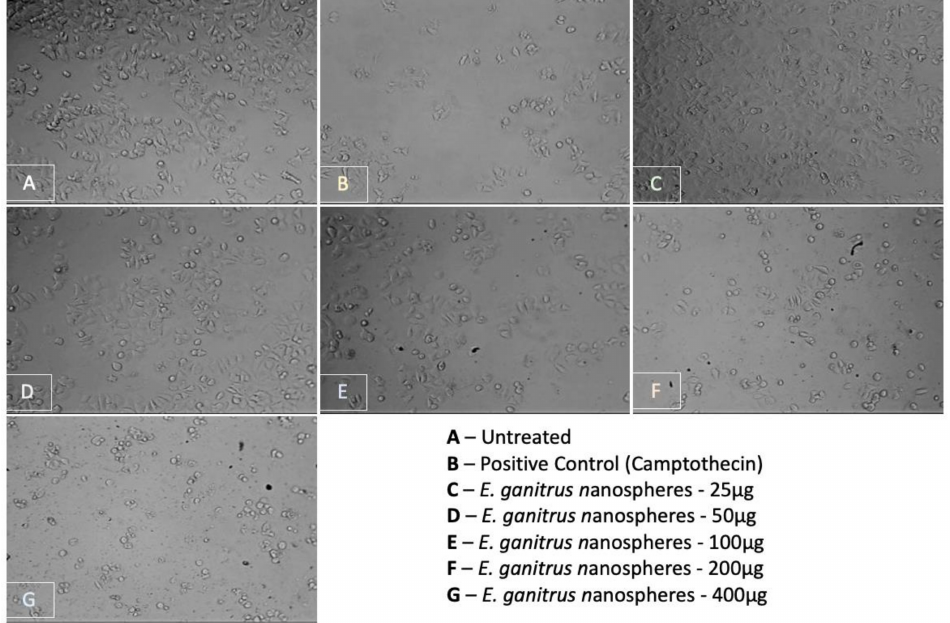
Figure 14. Photomicrographs of MCF-7 cells treated for 24 h with